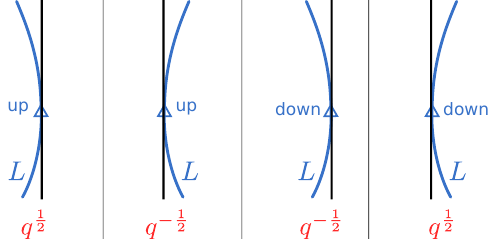
Figure 17 . Framing factors contributing to the overall weight (cid:11) ( e L ). The black line denotes a leaf of the WKB foliation. Here the word \up" or \down" next to a segment of L indicates the behavior in the x 3 -direction, which is not directly visible in the (cid:12)gure otherwise, since the (cid:12)gure shows the projection to C .